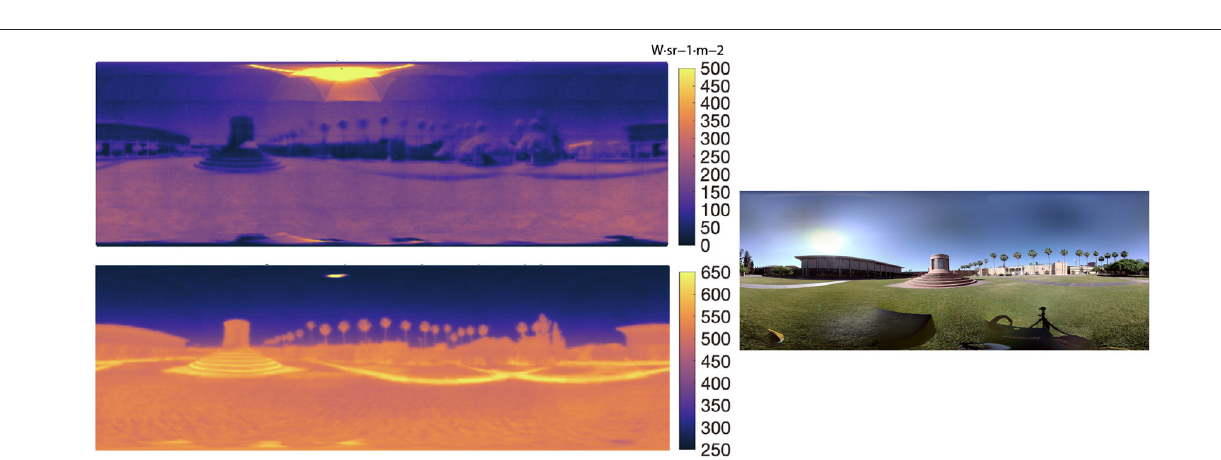
There is good agreement between the MaRTy and SMaRT-SL data, with the biggest discrepancy coming from the up direction where the significant sky portion may not be read with the same spectral sensitivity by the detectors due to filter cutoffs of